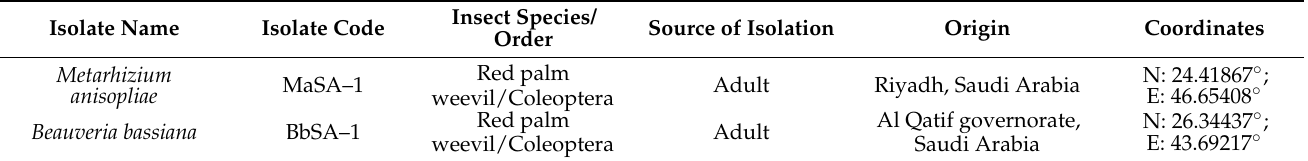
Table 1. Names and origins of entomopathogenic fungal isolates used in this